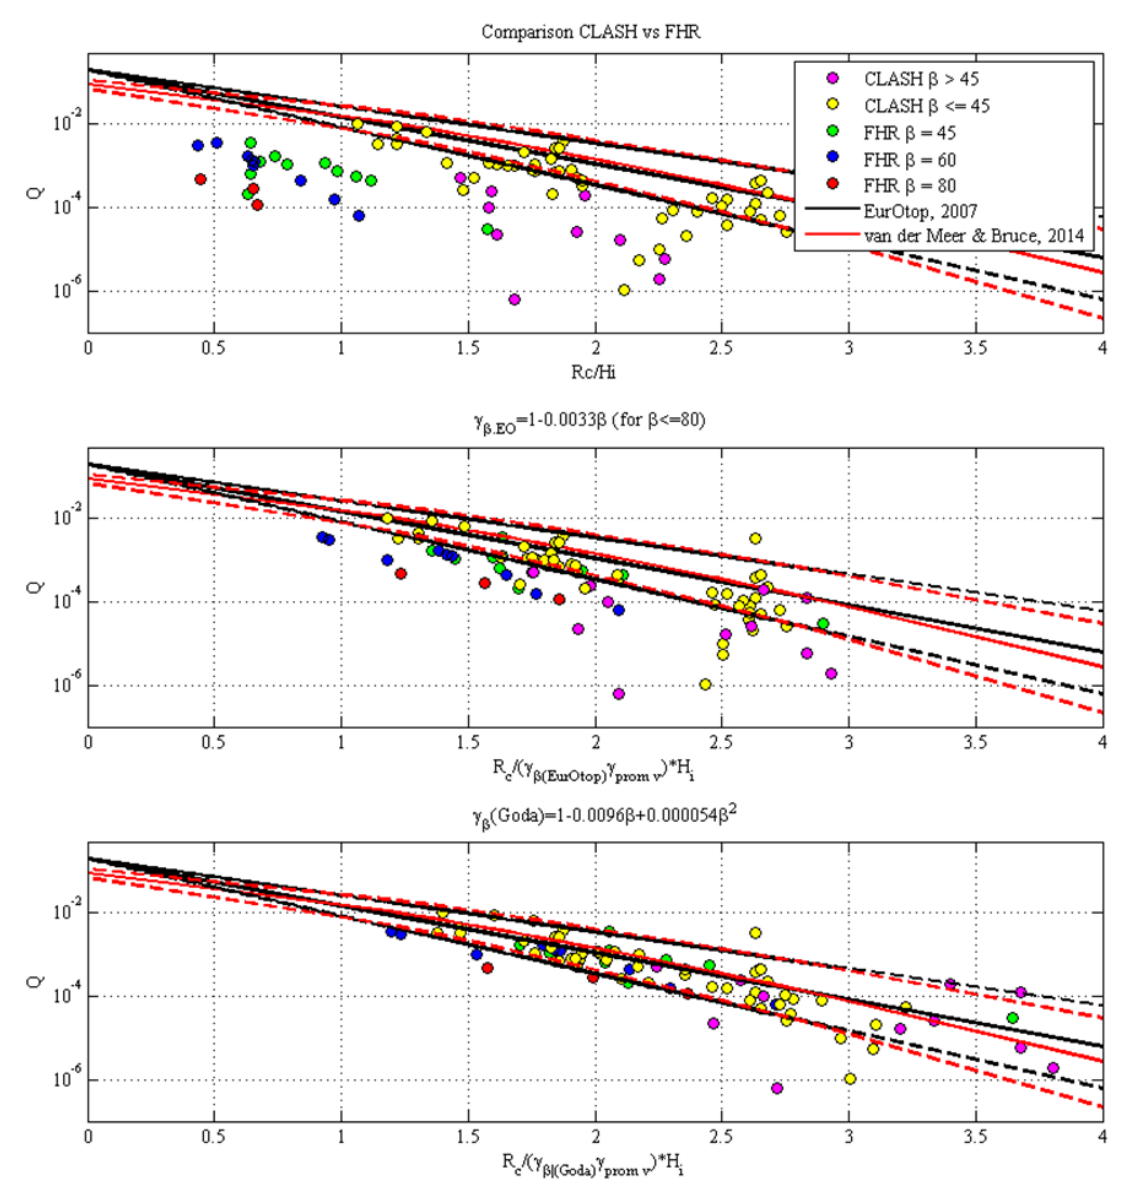
Figure 15. FHR and CLASH data vs. formula predictions.